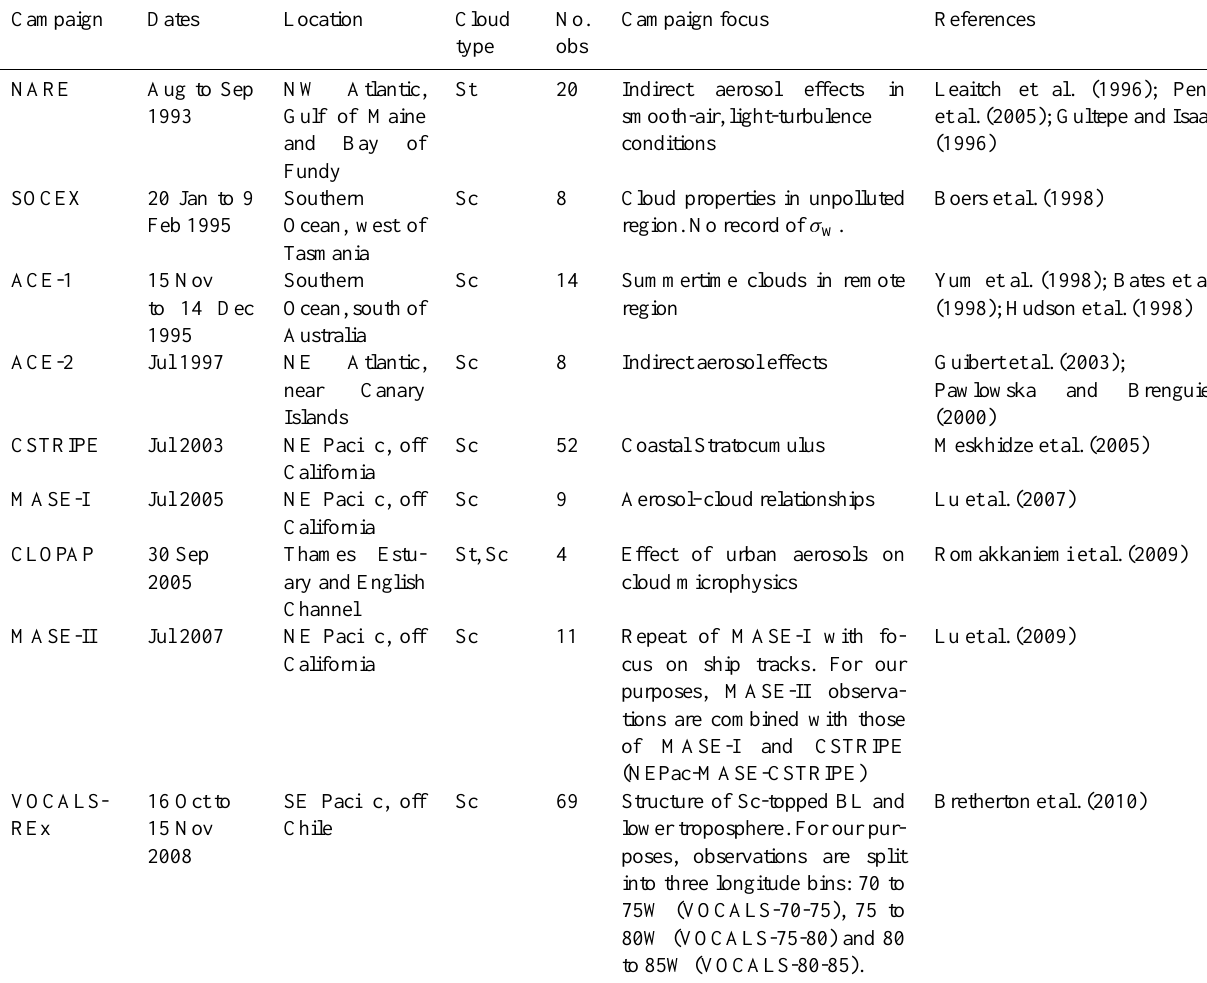
Table 3. Details of flight campaigns through marine stratiform clouds used for model evaluation.